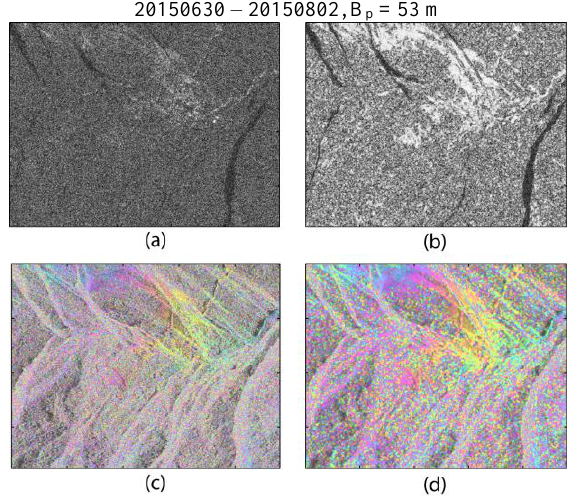
Figure 3. (a) and (b) Coherence generated with SBAS and SqueeSAR methods respectively. (c) and (d) The corresponding interferograms of (a) and (b),